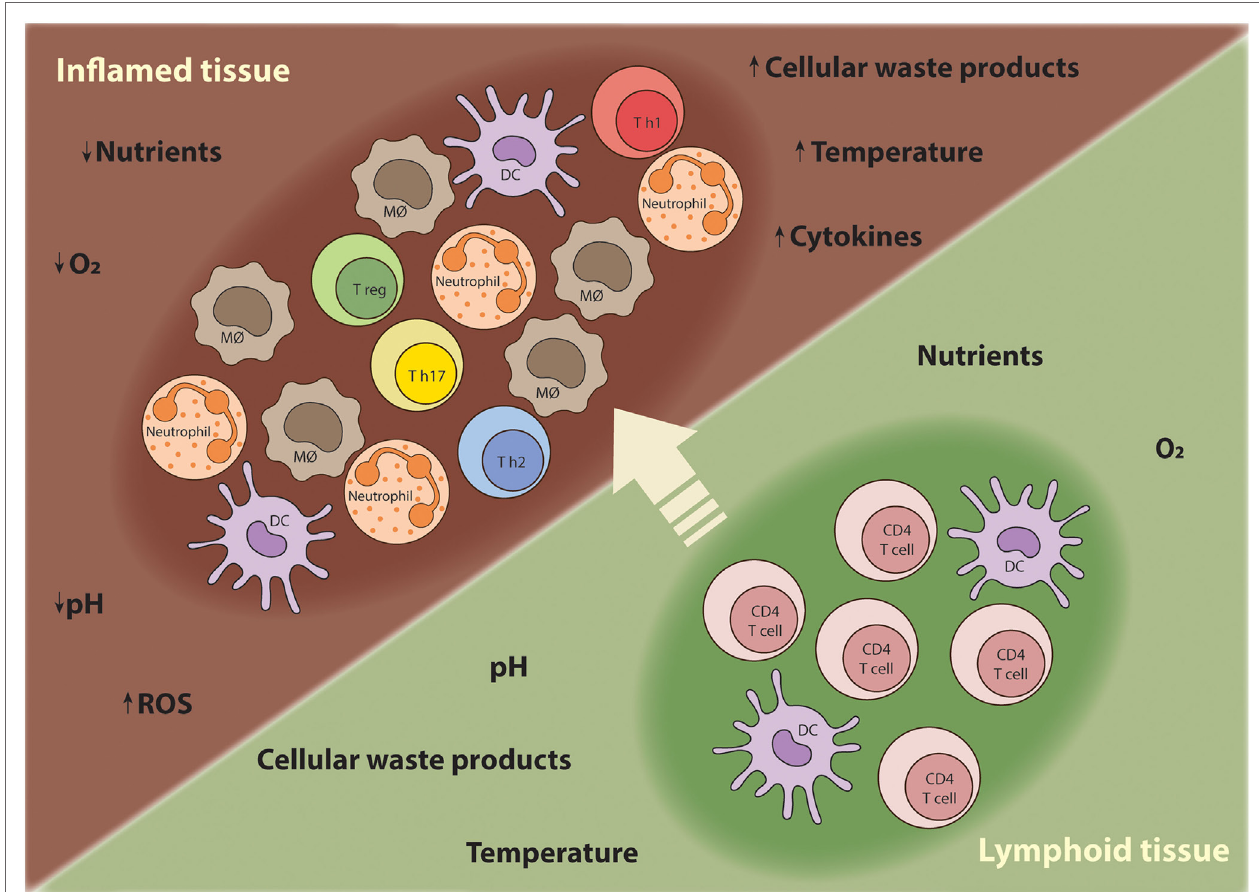
FiguRe 1 | T cells require metabolic flexibility to adapt to the chronic inflammatory environment. As T cells mature during an immune response, they migrate from nutrient-rich secondary lymphoid tissues to sites of inflammation where nutrients, oxygen, and other growth promoting factors become limited. Moreover, other innate inflammatory cells are recruited to the inflamed tissue and compete for nutrients. Thus, T cells have to metabolically adapt to these harsh conditions in order survive, proliferate, and perform their effector functions.